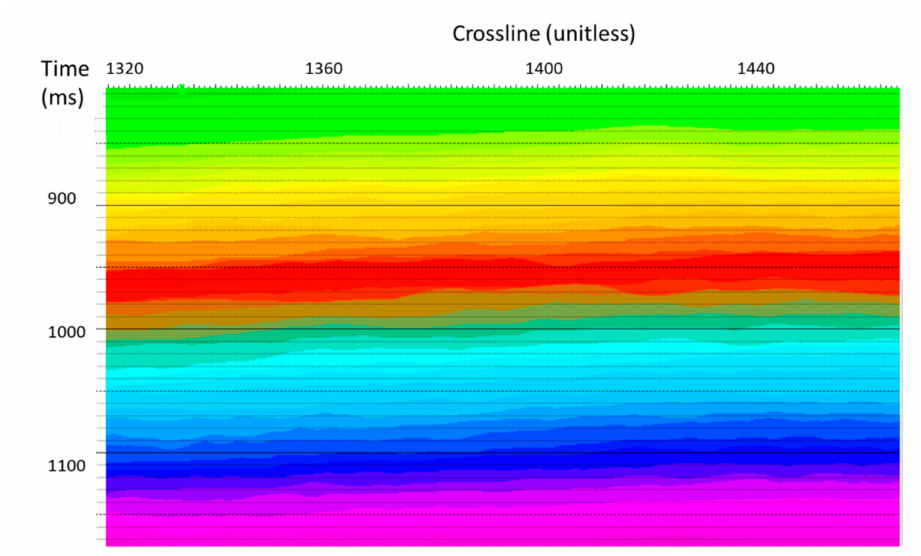
Figure 4. Inline example of relative geologic age volume. Each color represents a different seismically inferred relative geologic